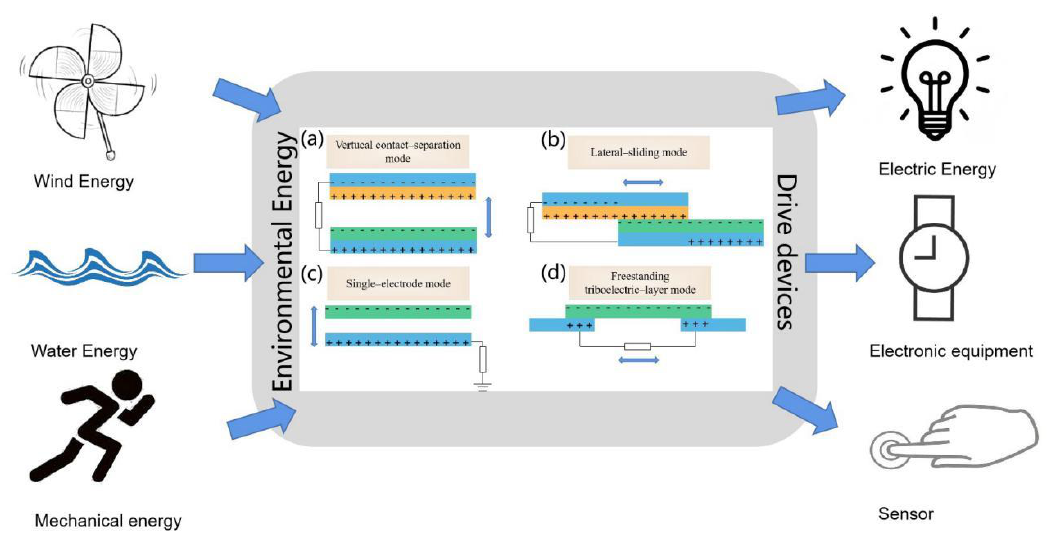
Figure 2. Four modes of TENGs: ( a ) vertical contact separation mode; ( b ) lateral sliding mode; ( c ) single-electrode mode; ( d ) free-standing triboelectric layer mode.